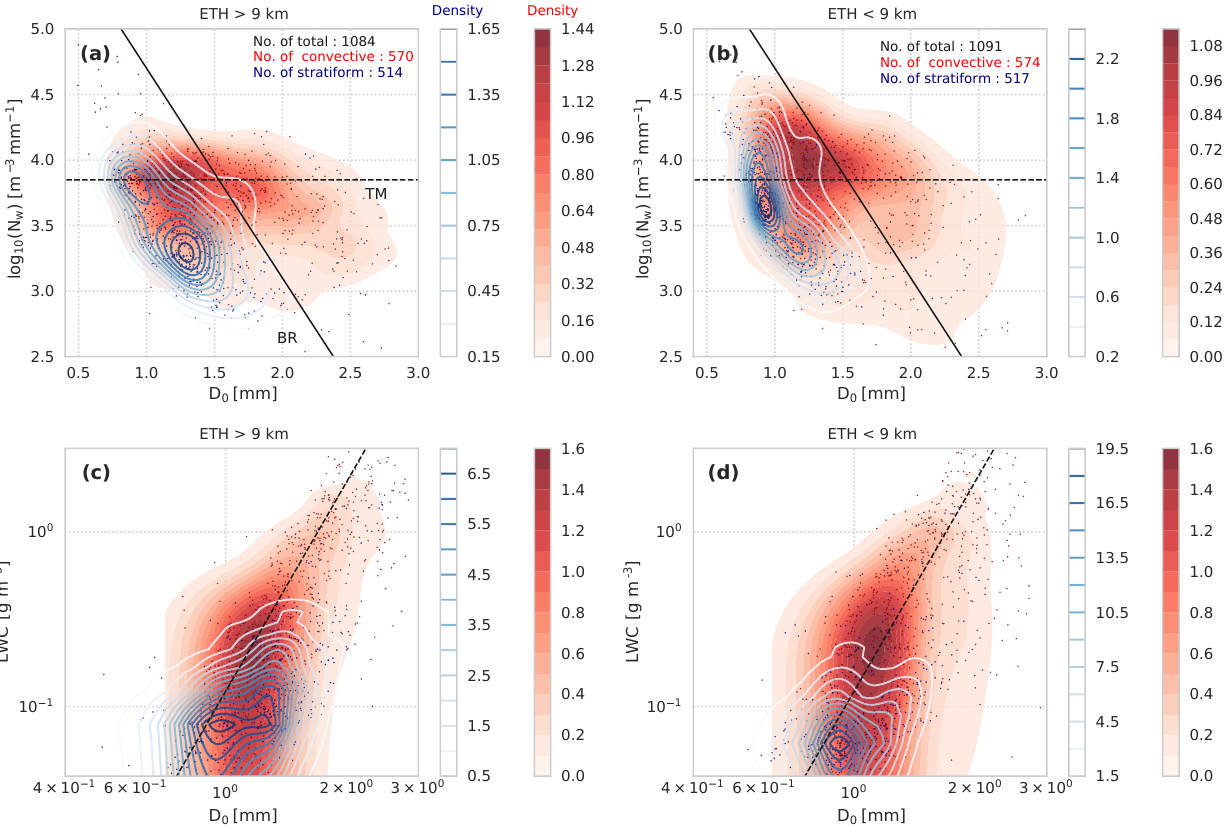
Figure 9. Scatter plots of log 10 ( N w ) versus D 0 and LWC versus D 0 , overlaid by the contours representing the RWP-based classifications for convective (red colors) and stratiform (blue lines) precipitating columns and for ETH > 9km (a, c) and ETH < 9km (b, d) situations.